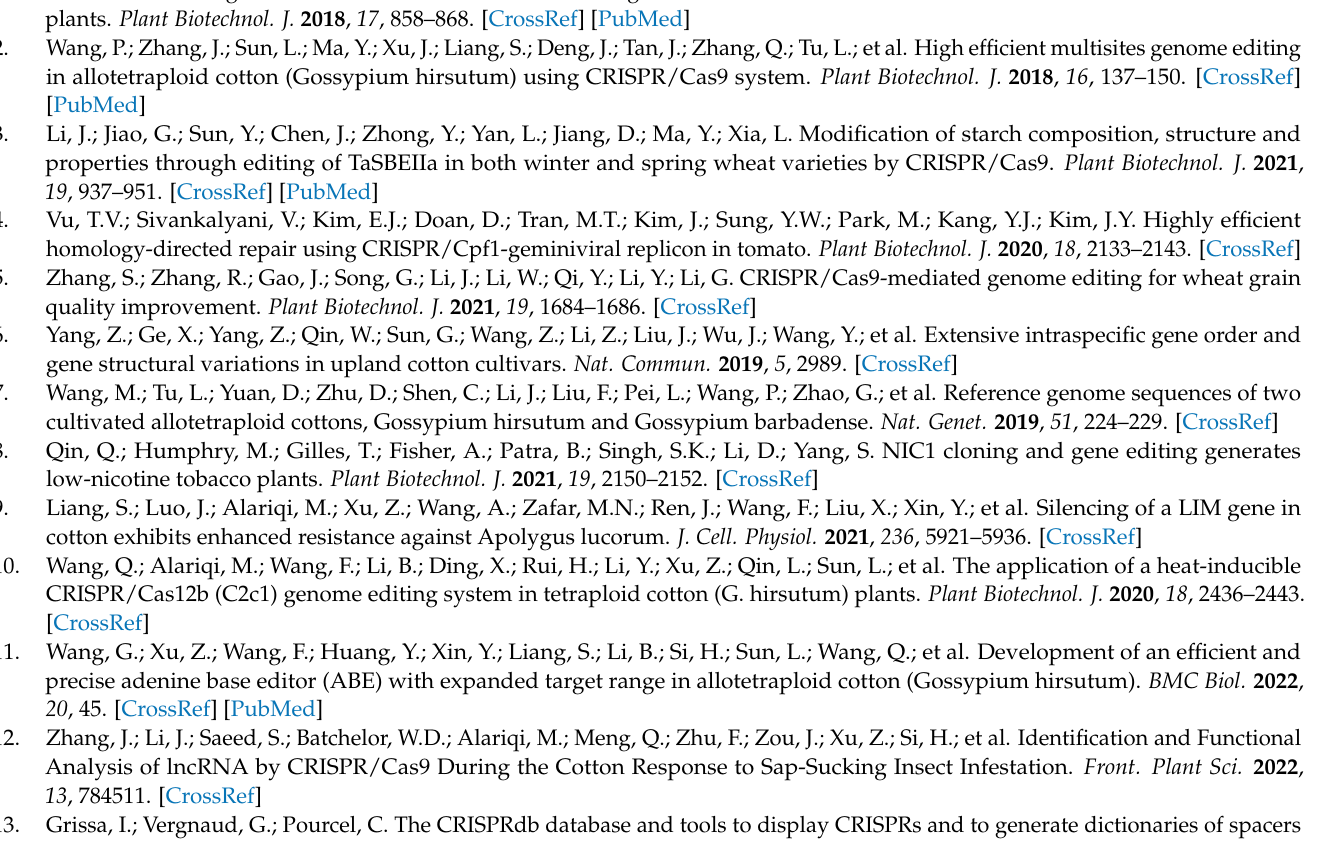
information tab for this article. Table S1: Primers used for vector construction and transgenic plant detection. Table S2: Mutation Frequencies of three vectors with GhCLA1 sgRNAs in cotton T0 lines. Table S3: Statistics of mutation profiles using three systems in T0 generation